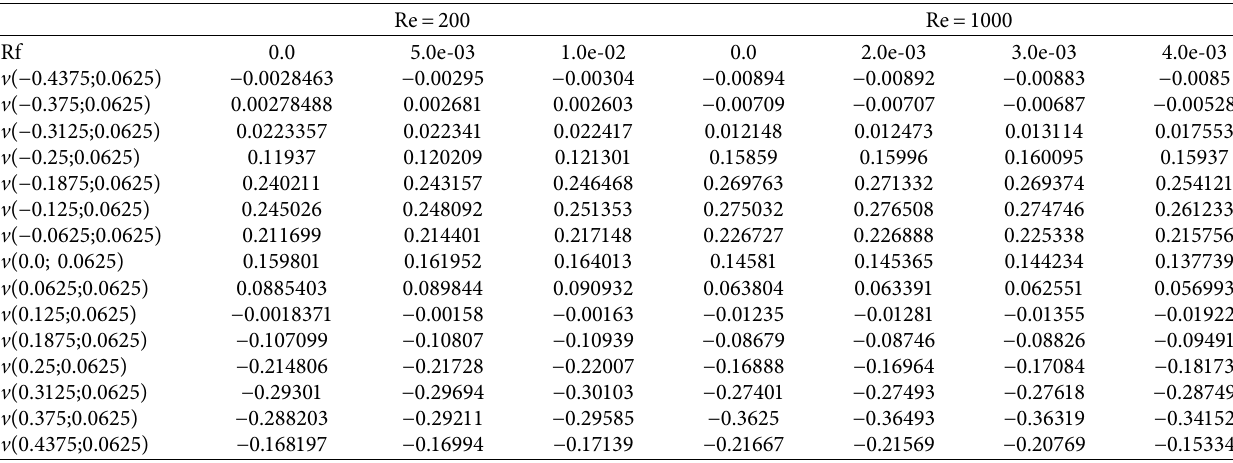
Table 2: Vertical velocity component “ v ” for Re � 200 and Re � 1000 with varying values of the fluid relaxation parameter. Re � 200 Re � 1000